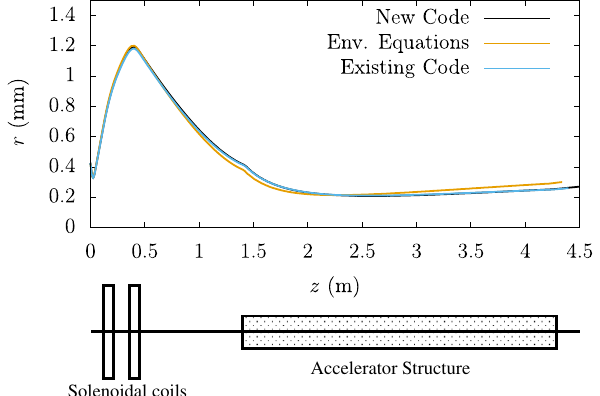
FIG. 10. Time evolutions of transverse rms beam size for the SPring-8 rf gun injector system with focusing fields.